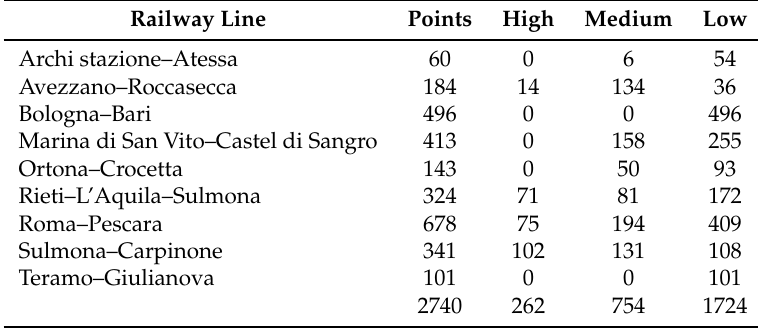
Table 14. Distribution of the sampled points inside the three classes of exposure.